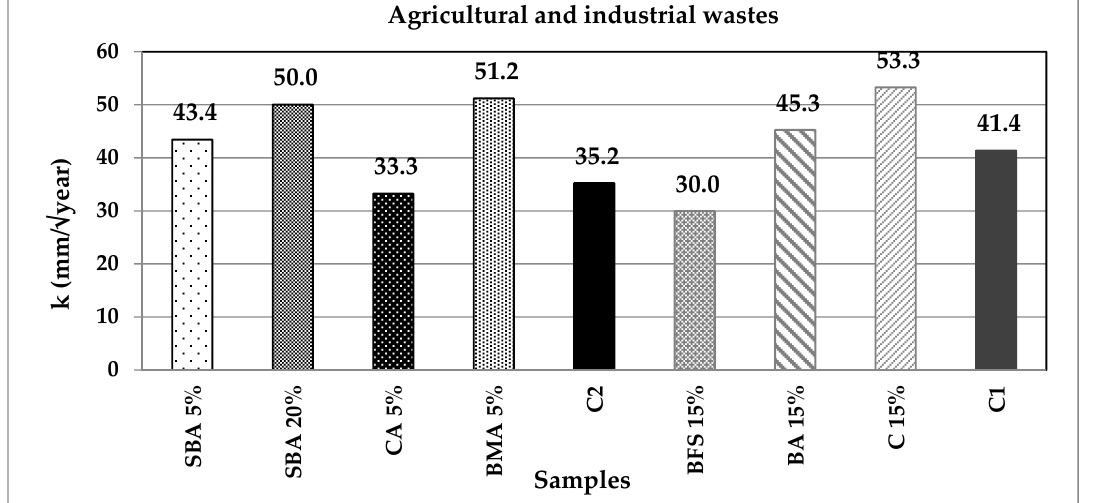
Figure 14. Constant k for the minerals and fibres group of additions. Figures 15 and 16 present the uniaxial compressive strength values of the analysed specimens; it is notable that the mixtures with higher k values and lower carbonation times also present lower mechanical resistances compared to the control samples. Two samples stand out from the rest: SBA and MK; they present higher mechanical properties while at the same time promote carbonation; in the case of SBA, it can be observed how the greater is the substitution percentage, the higher is the carbonation velocity and the lower is the mechanical resistance.